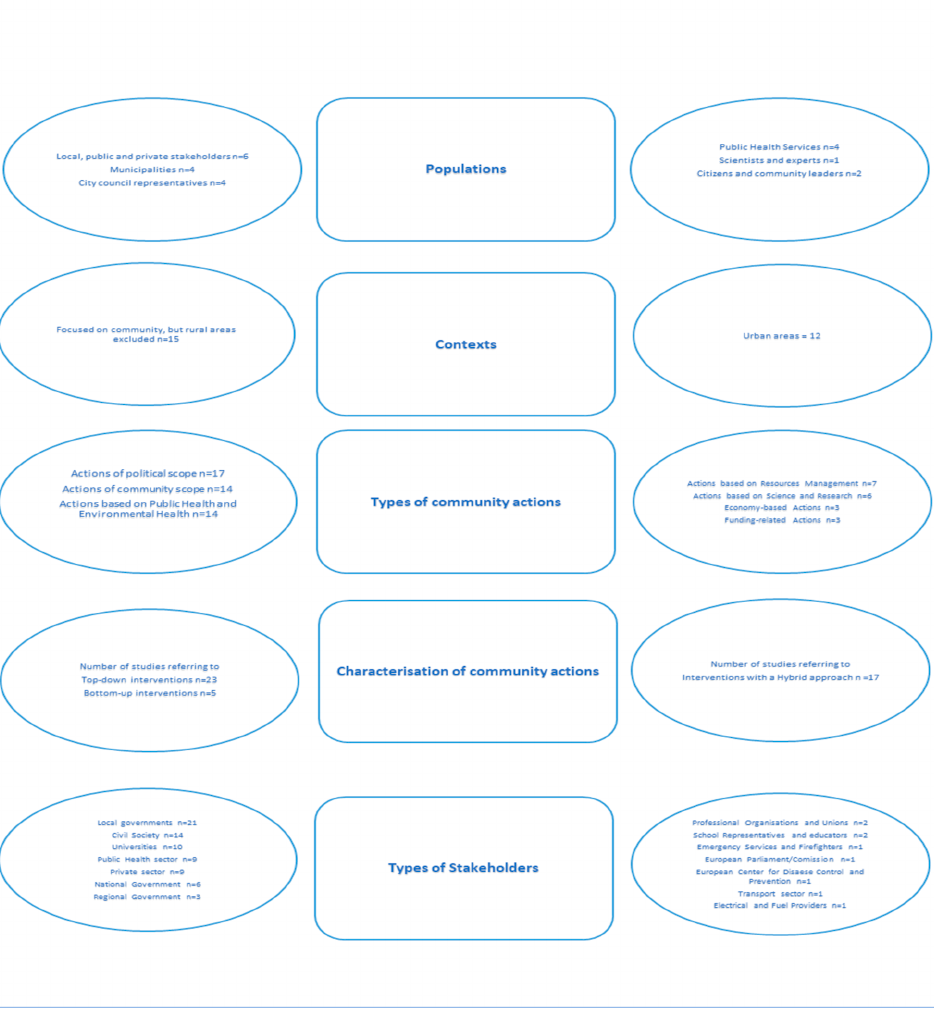
Figure 3. Overview of identified populations with corresponding contexts, types of community actions led or implemented, characterization of community actions according to each community intervention model and stakeholders involved.